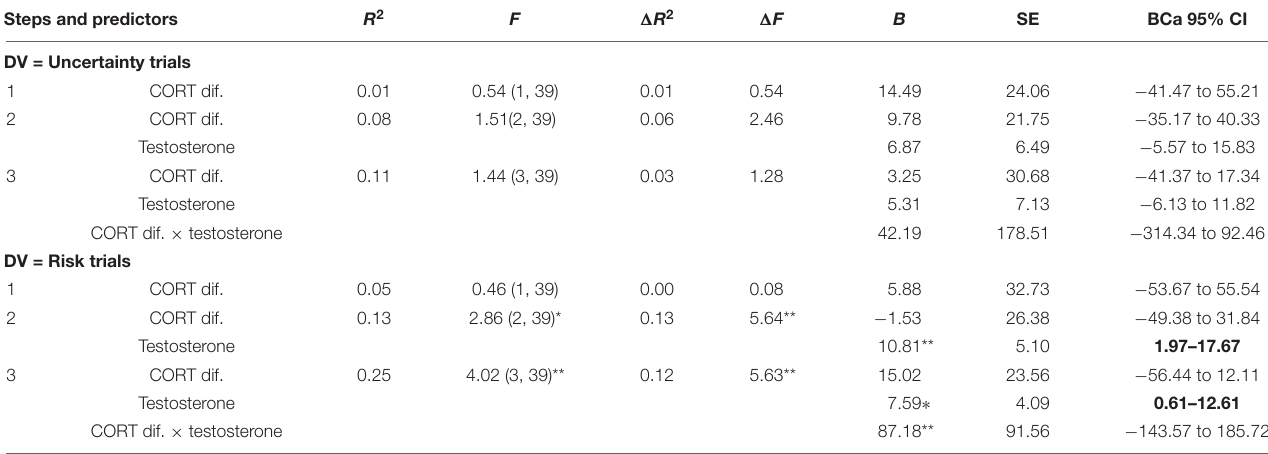
TABLE 2 | Results of hierarchical regression using cortisol regulation (step 1), testosterone (step 2), and cortisol decline × testosterone (step 3) to explain Iowa gambling task (IGT) decision-making in the uncertainty and risk phases. Steps and